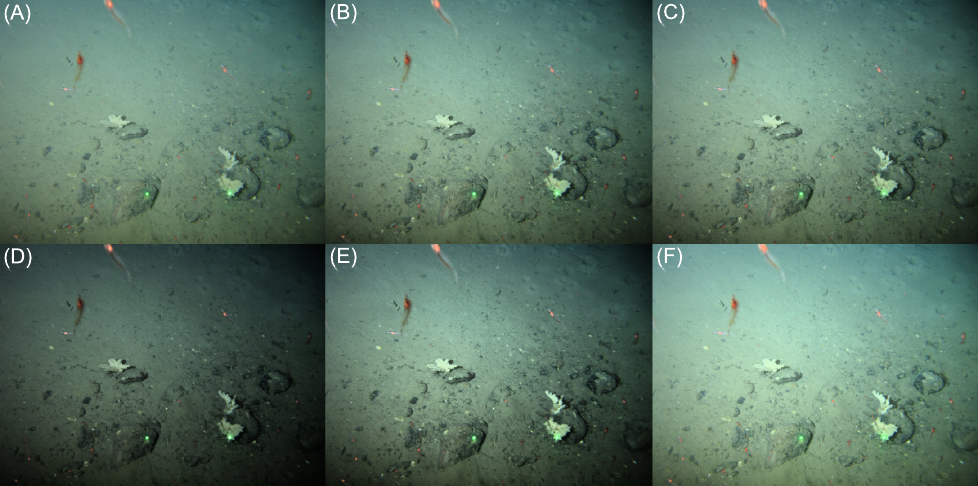
Figure 8. WTM example: ( A ) Input image, ( B ) User-adjusted Output, ( C ) WTM approximation of Output image ( B ) and ( D – F ) parameterised WTM adjustments of ( A